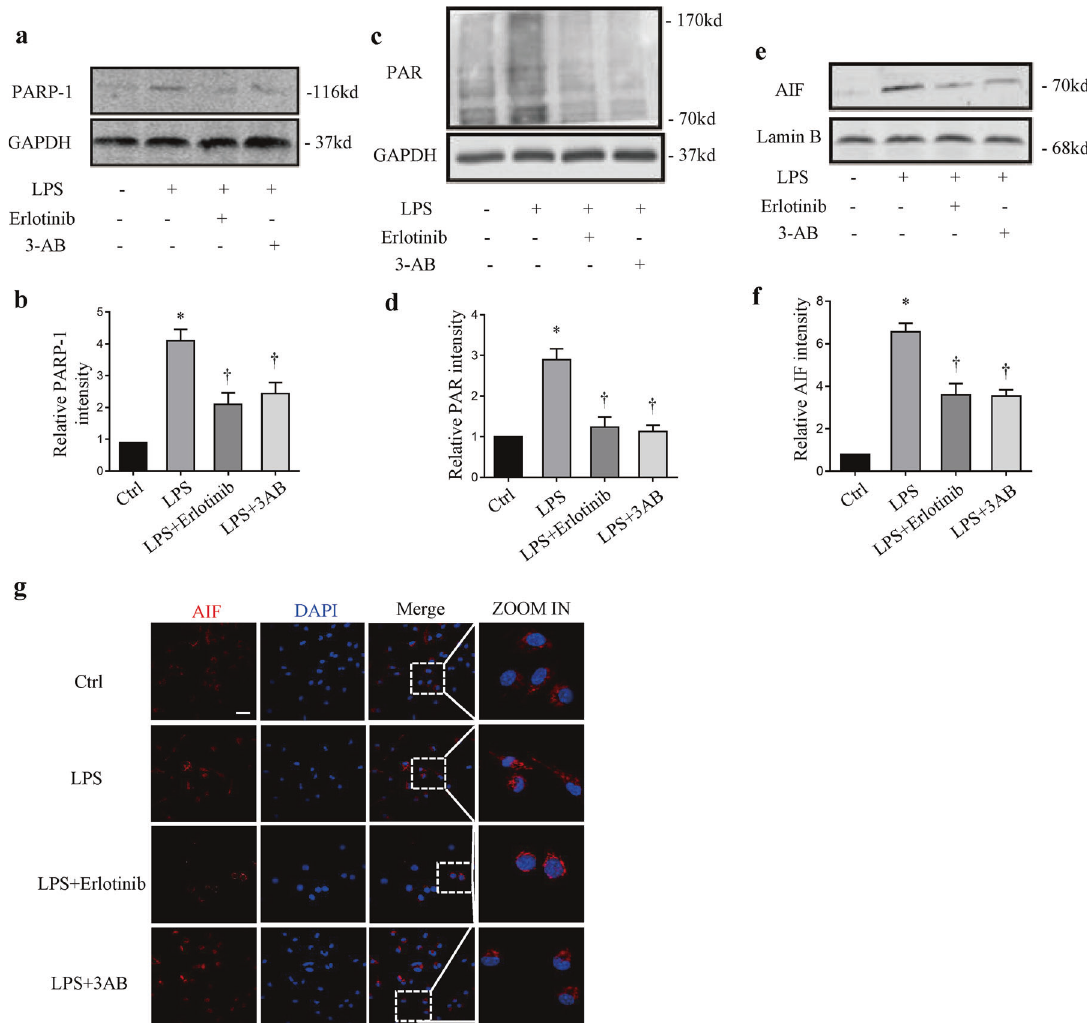
( b ) and PAR ( d ) expressions. e Immunoblot analysis of AIF and Lamin B amount in nuclei. f Mensuration of AIF expression. g Fluorescence images indicated that erlotinib and 3-AB pretreatment limited the AIF translocation (up panel; scale bar, 100 μ m). Error bars represent SD ( n = 3). * P < 0.05 as compared with NC; † P < 0.05 as compared with LPS